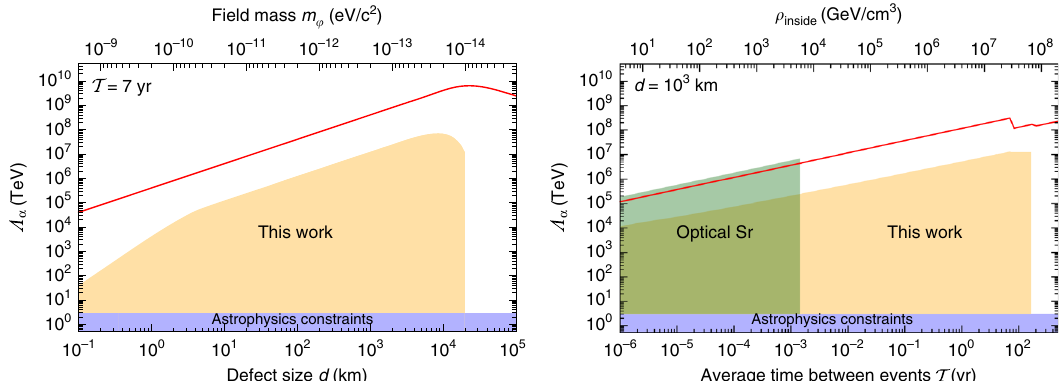
Fig. 5 Constraints on the coupling of dark matter to electromagnetism. Limits (90% con fi dence level) on the energy scale Λ α as a function of the wall width d and average time between encounters T . The shaded yellow region shows the Global Positioning System limits from this work (assuming Γ α (cid:6) Γ q ; e = p ), the shaded green region shows the limits derived from an optical Sr clock 38 , and the shaded blue region shows the astrophysical bounds 39 . The solid red line shows the potential discovery reach using the global network of Global Positioning System microwave atomic clocks. For T ≲ 7 yr , the Global Positioning System reach is limited by the modern Rb block IIF satellite clocks 46 ( σ y ð 30 s Þ (cid:2) 10 (cid:3) 11 ), and for T ≲ 7 yr , the reach is limited by the older Rb (block IIR, IIA and II) clocks ( σ y ð 30 s Þ (cid:2) 10 (cid:3) 10 ). Compared to more accurate optical clocks, microwave clocks provide additional sensitivity to Λ q and Λ e / p (optical clocks only have sensitivity to Λ α